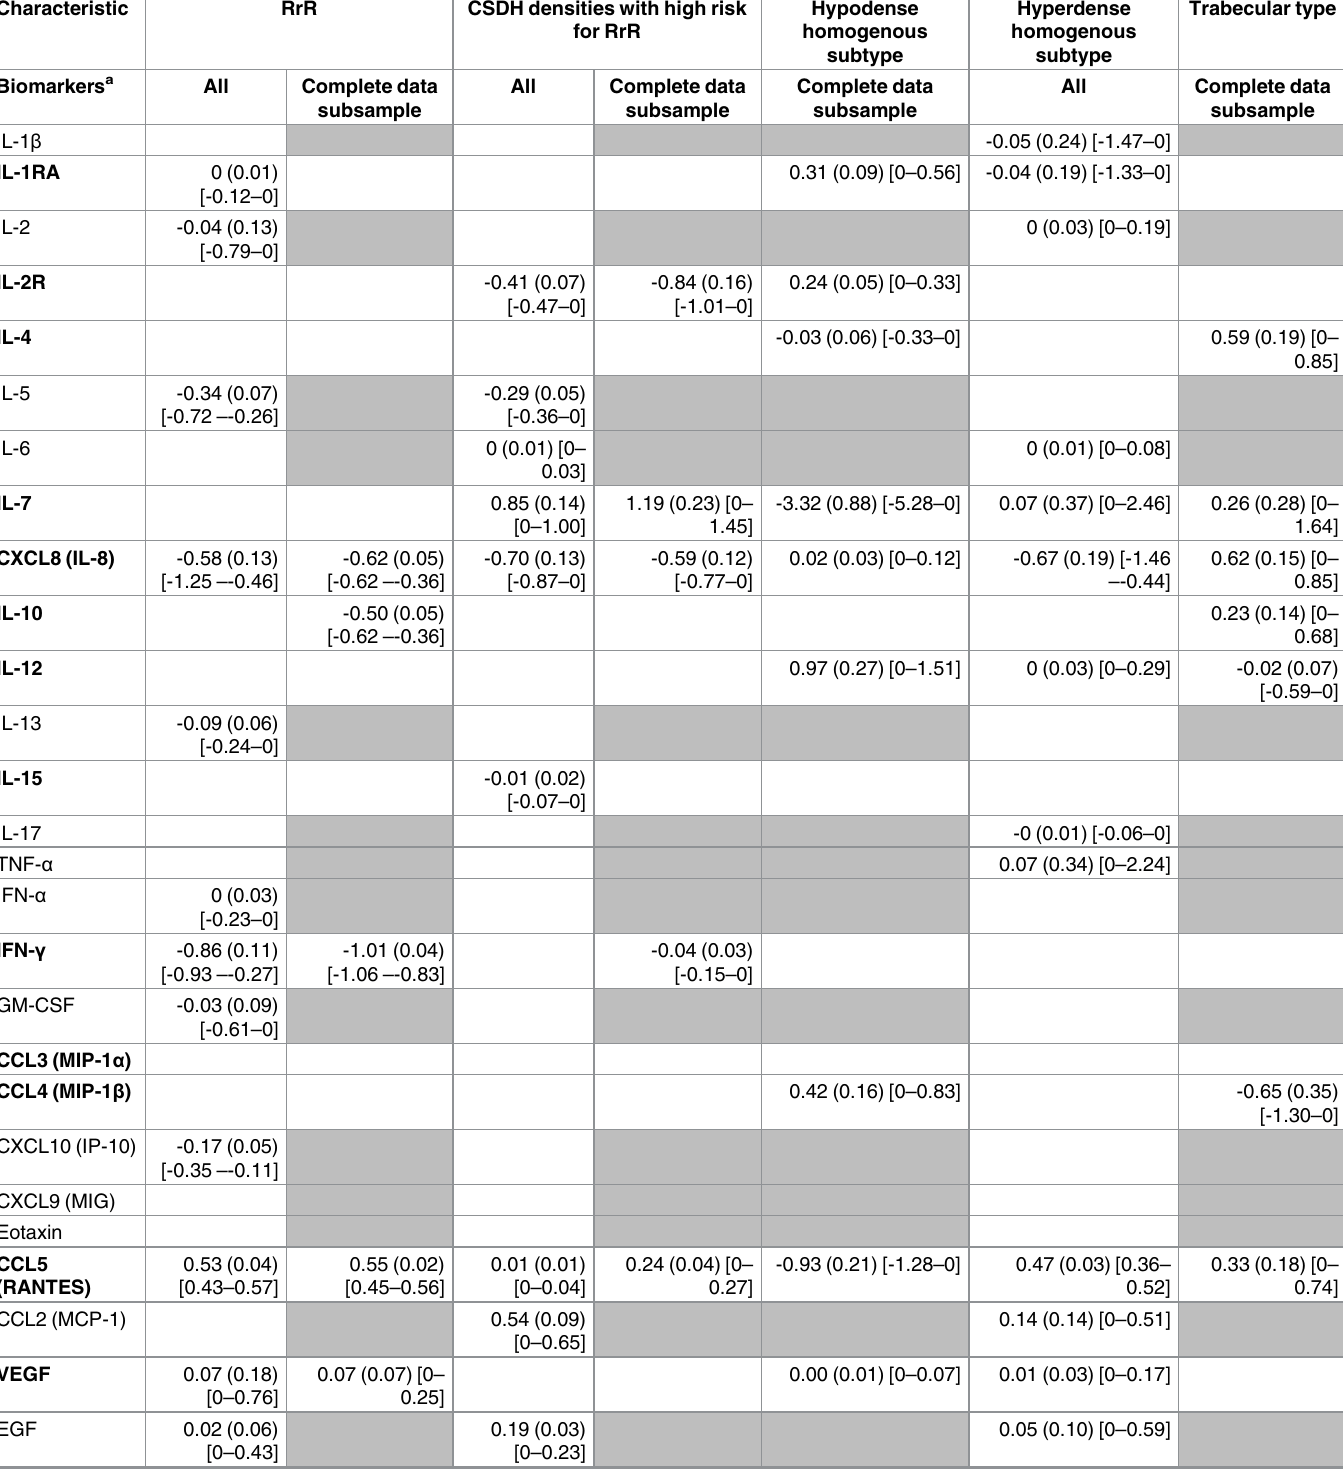
Table 3. Mean, (SD) and range expressedas [minimum–maximum] of lasso coefficients of biomarkers on characteristics of CSDH patients described in Table 1 from 100 rounds of cross-validation